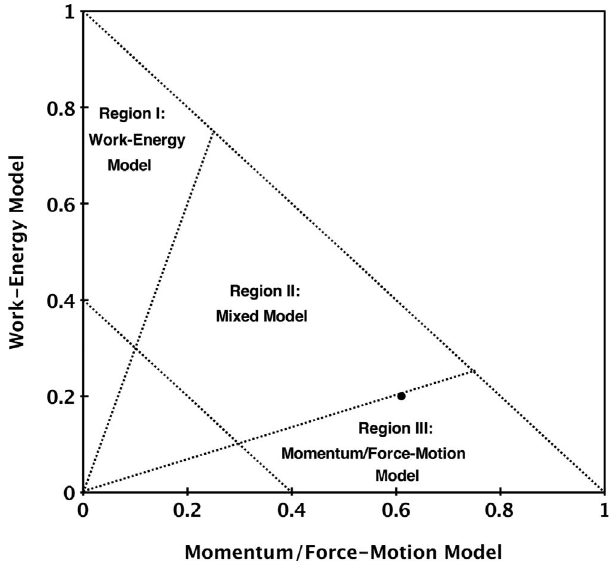
FIG. 17. A model plot of students’ answering four MIET